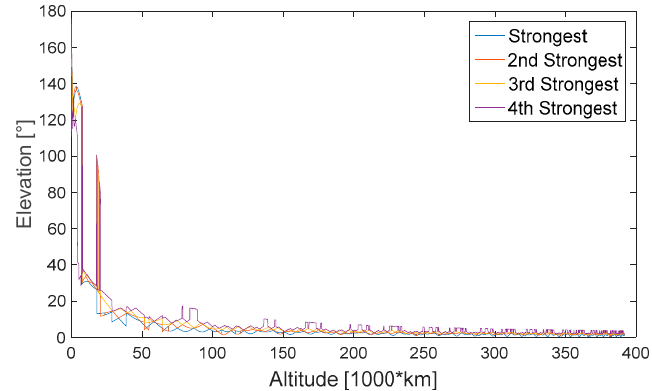
Figure 33. Elevation values at which the four strongest signals are available at the receiver’s antenna.